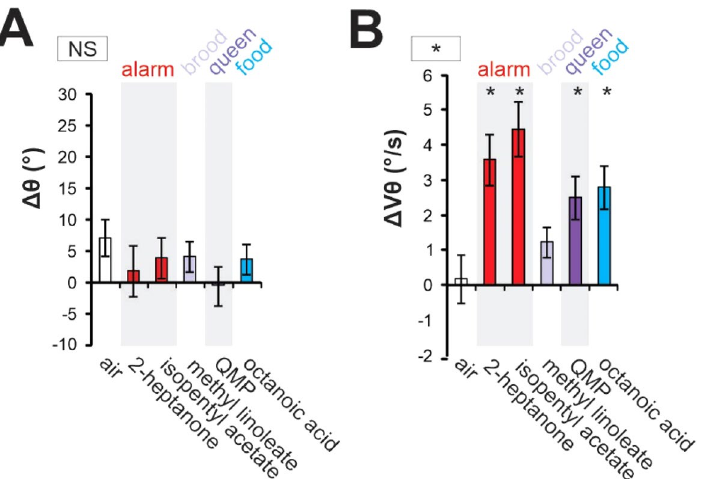
Figure 6. Odor-induced antennal responses in newly emerged bees. ( A,B ) Histograms showing the change in antennal movements in response to odor presentation (during–before odor) in terms of ( A , C ) angular position (Δθ) and ( B , D ) angular velocity (ΔVθ). Stimuli include an air control (white), two alarm pheromone components (red), one brood pheromone component (light purple), the queen mandibular pheromones (dark purple) and a major component of the royal jelly odor (blue). The asterisk in the square next to the graph indicates a significant heterogeneity among odorants (RM-ANOVA, *p < 0.05). NS: non-significant. Asterisks on the graphs indicate significant differences in Dunnett post-hoc tests comparing each value to the air control (*p <